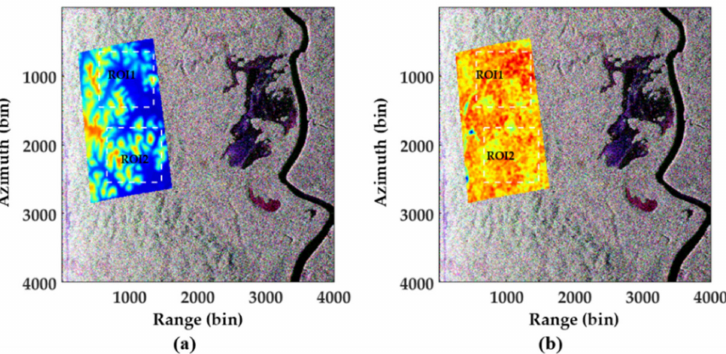
Figure 2. The LiDAR DTM and CHM in the Pauli RGB SAR images: ( a ) LiDAR DTM; ( b ) LiDAR CHM. The white dotted areas are two regions of interest (ROI).